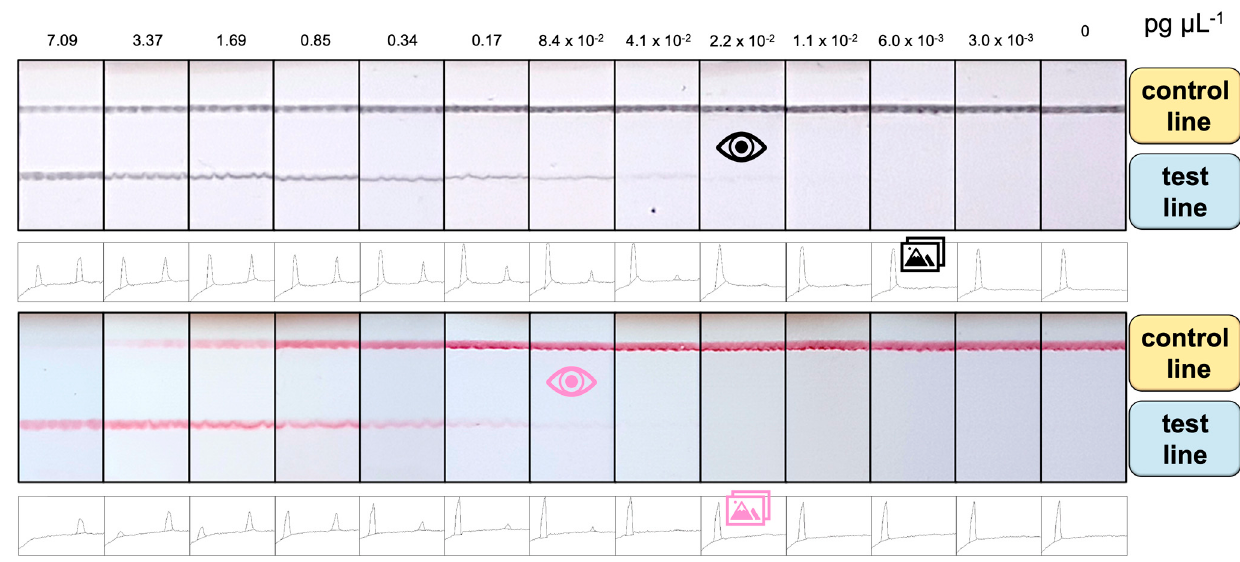
Figure 5. Results obtained for the LFA at template amounts ranging from 0.00 to 7.09 pg μ L − 1 (0 to 1.5 × 10 4 CFU mL − 1 ) of E. coli , based on Av ‐ CNPs (upper panel) and streptAv ‐ AuNPs (lower panel). The relative areas obtained after processing the images, plotted in Figure 6, are also shown for both signal ‐ generating systems. The eye icon indicates the visual LODs, while the photo icon indicates the LOD obtained by processing the images and determining the areas.